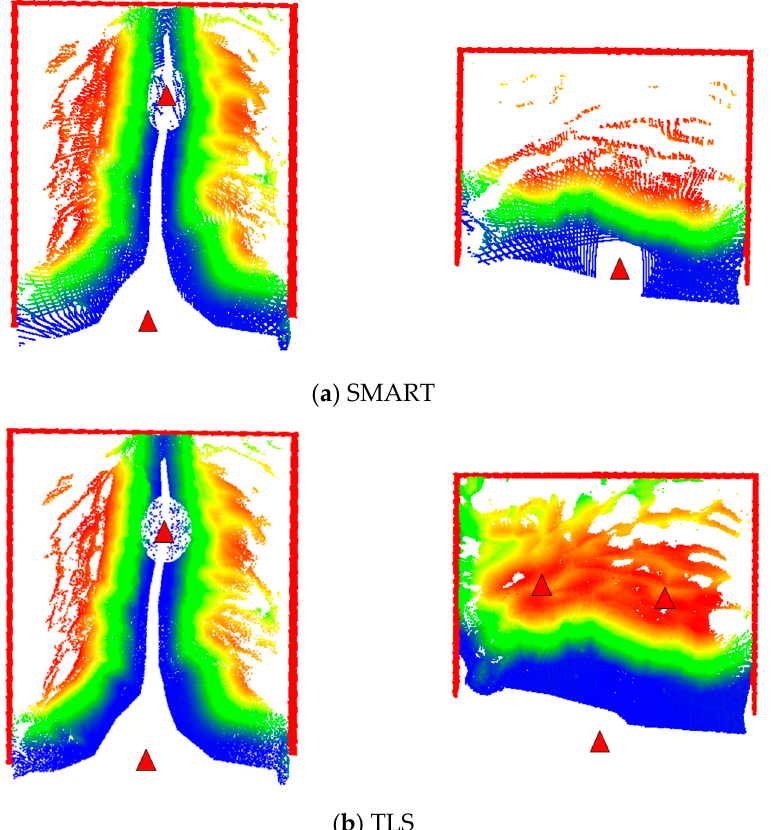
Figure 27. Stockpile surface occlusions from the SMART and TLS for Lebanon ( left ) and US-231 ( right ) facilities. Facility boundaries are indicated in red (point clouds are colored by height). Triangular markers are scan stations of the corresponding platforms. Table 6. Comparison of volume estimates from the SMART and TLS